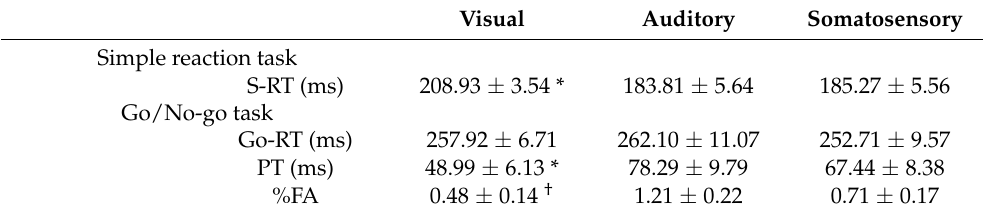
Table 1. Behavioral data for each modality. Visual